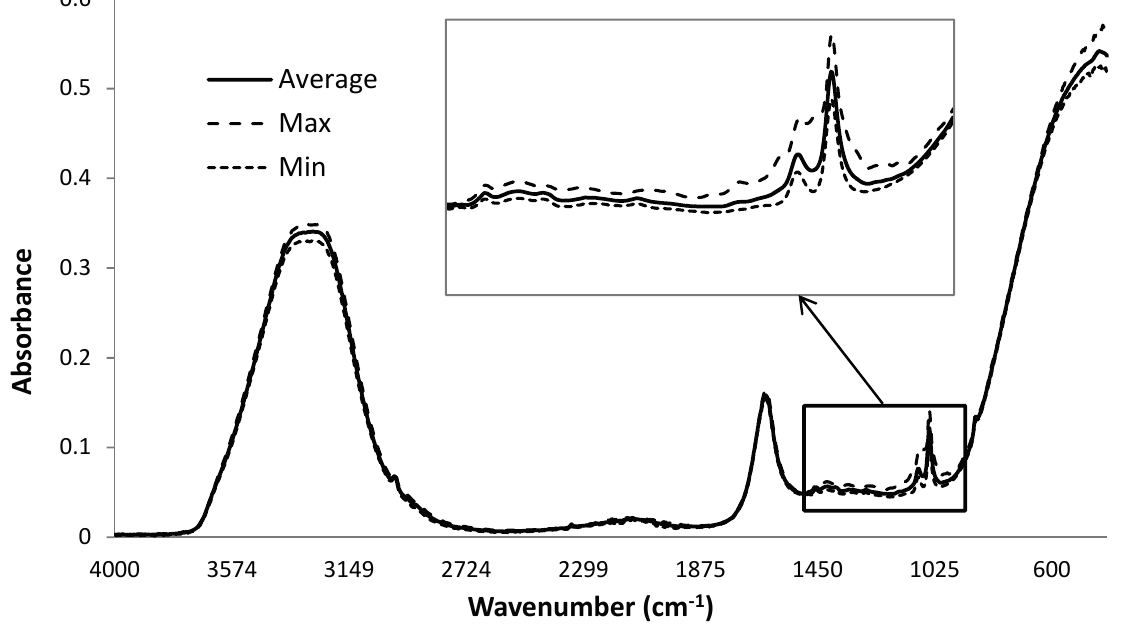
Figure 1. Mean, maximum and minimum ATR-MIR spectra (4000–400 cm − 1 ) obtained from (degassed) sparkling wine samples ( n =